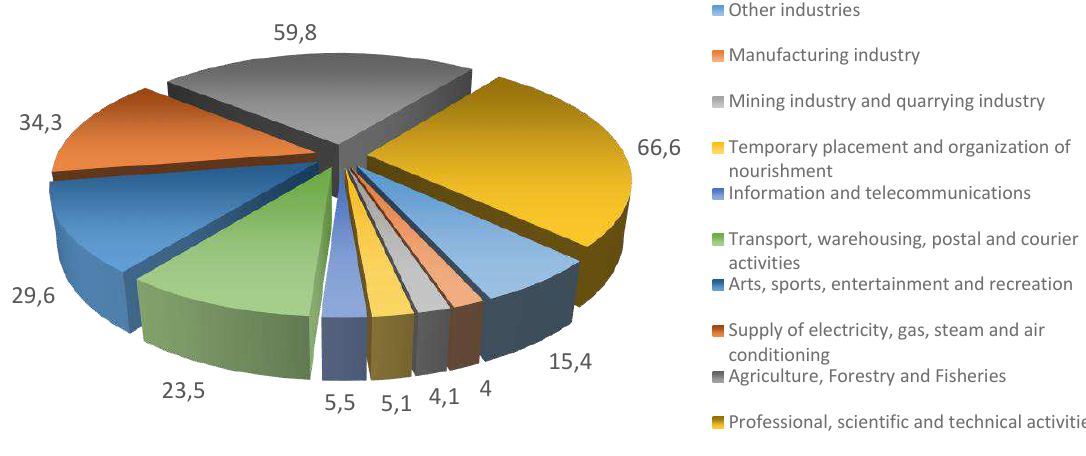
Figure 1. The share of the public sector in the economy for the first quarter of 2018